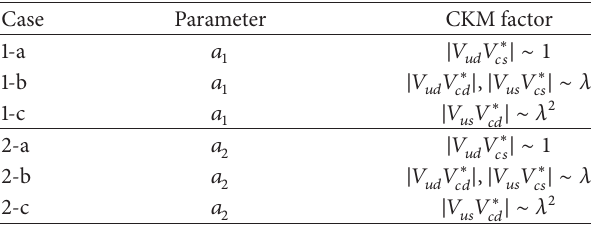
Table 7: Classification of the nonleptonic charmonium weak